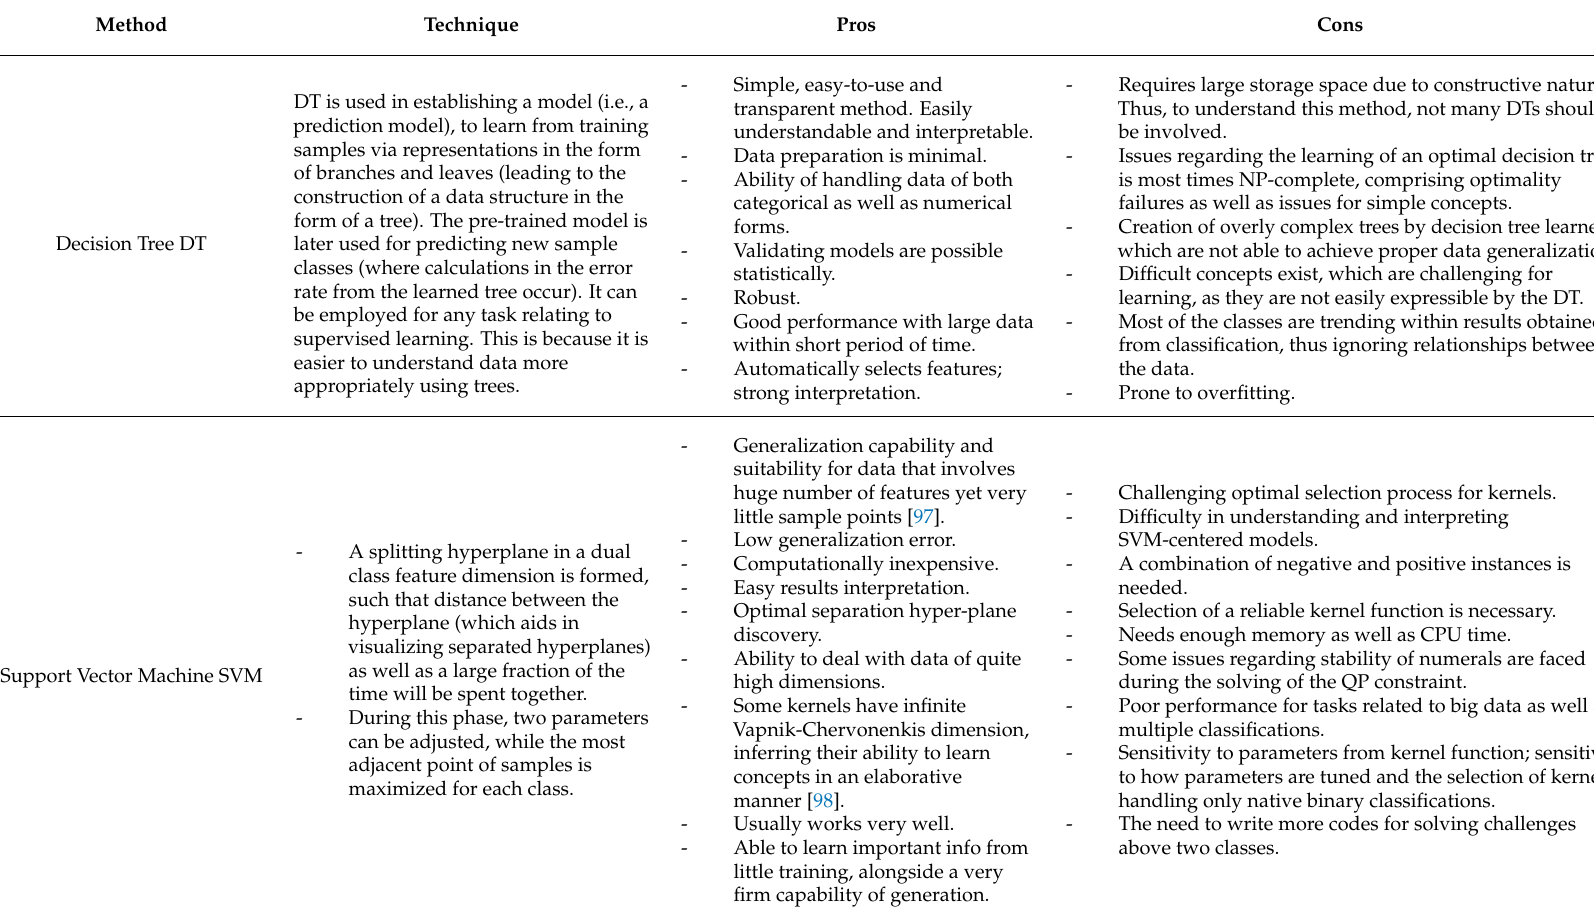
Table 4. Pros and cons of techniques for common classifiers for the use of